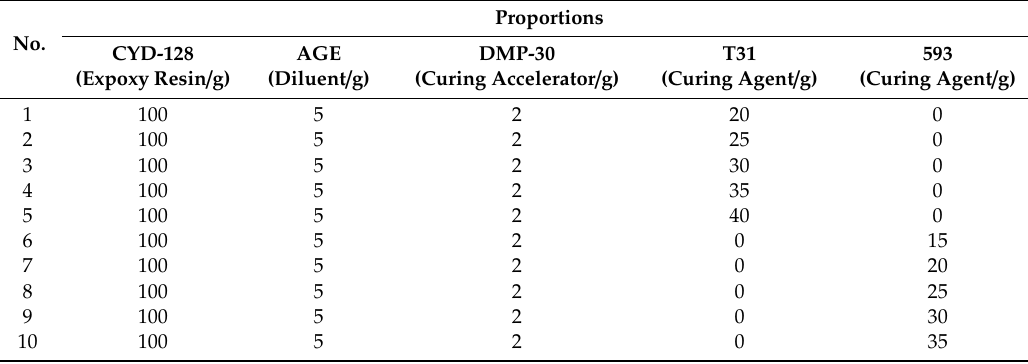
Table 3. The proportions of a two-component epoxy